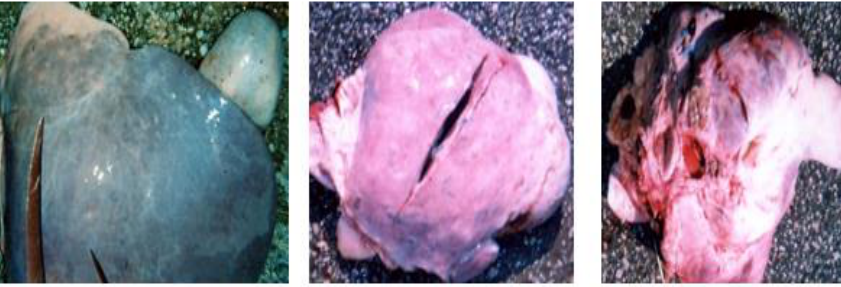
Figure 8. Hepatic lesions.